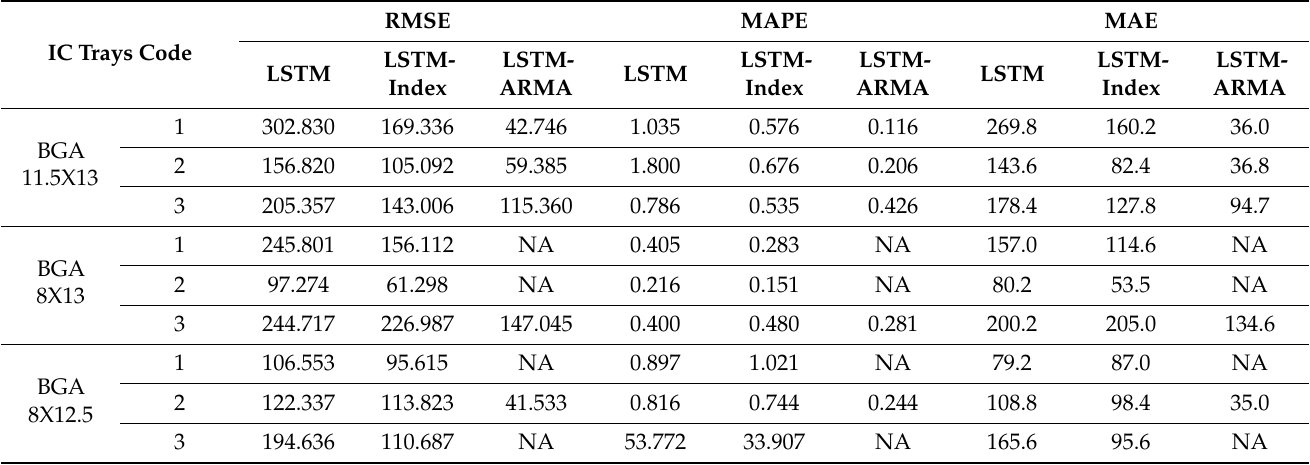
Table 10. Comparison of RMSE, MAPE, and MAE results for three different IC